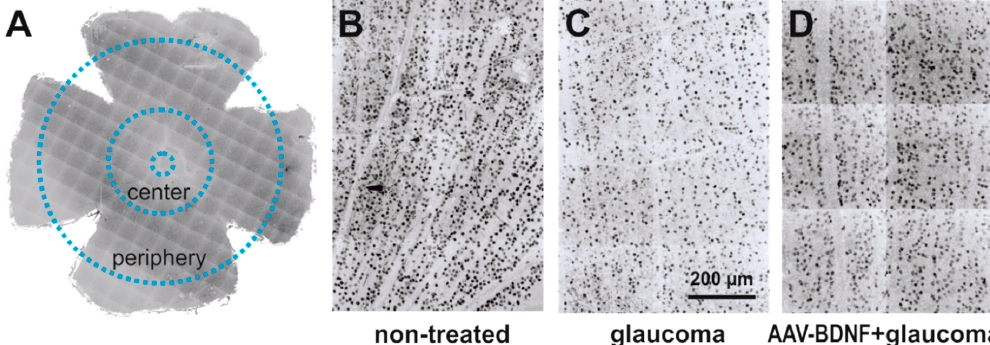
Figure 2. The effect of glaucoma and AAV-BDNF treatment on the retinal ganglion cell (RGC) number was examined by counting RGCs in 300 μ m × 300 μ m m fields in the central and peripheral parts of the retina ( A ). Images from non-treated eye ( B ) were compared to images from contralateral glaucomatous ( C ) or glaucomatous and AAV-BDNF treated eyes ( D ). RGCs were immunolabeled with anti-Brn3a antibody, a widely accepted marker of rodent RGC [31].